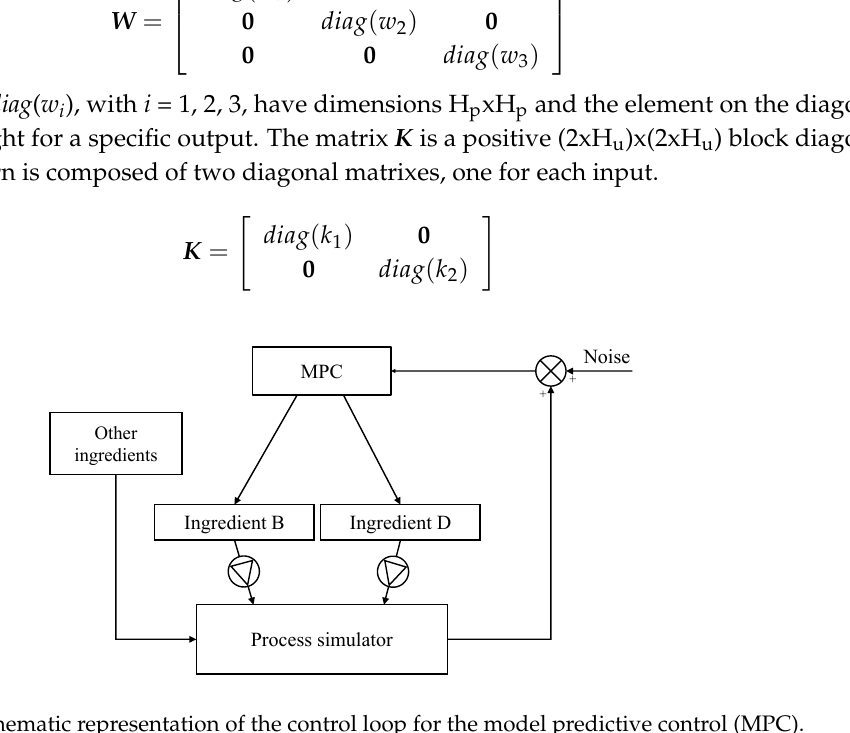
Figure 8. Schematic representation of the control loop for the model predictive control (MPC).